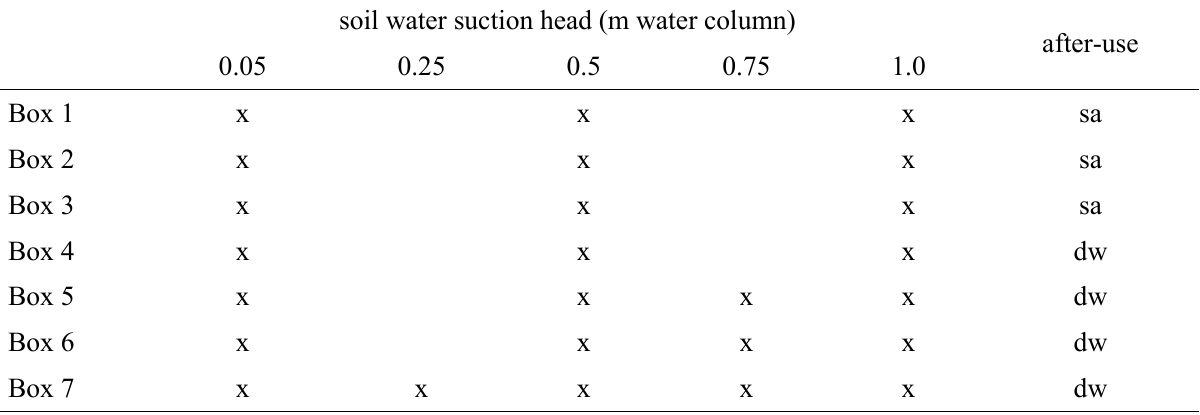
Table 3. Schematic description of the experimental design with six different soil water suction heads, seven boxes and two after-uses of the samples. The boxes that were subjected to CO 2 measurements at each soil water suction head are marked ‘x’. Each box contained one sample from each of the 13 soils. The after-use of the samples in each box was for either soil analyses (sa) or dry weight (dw)